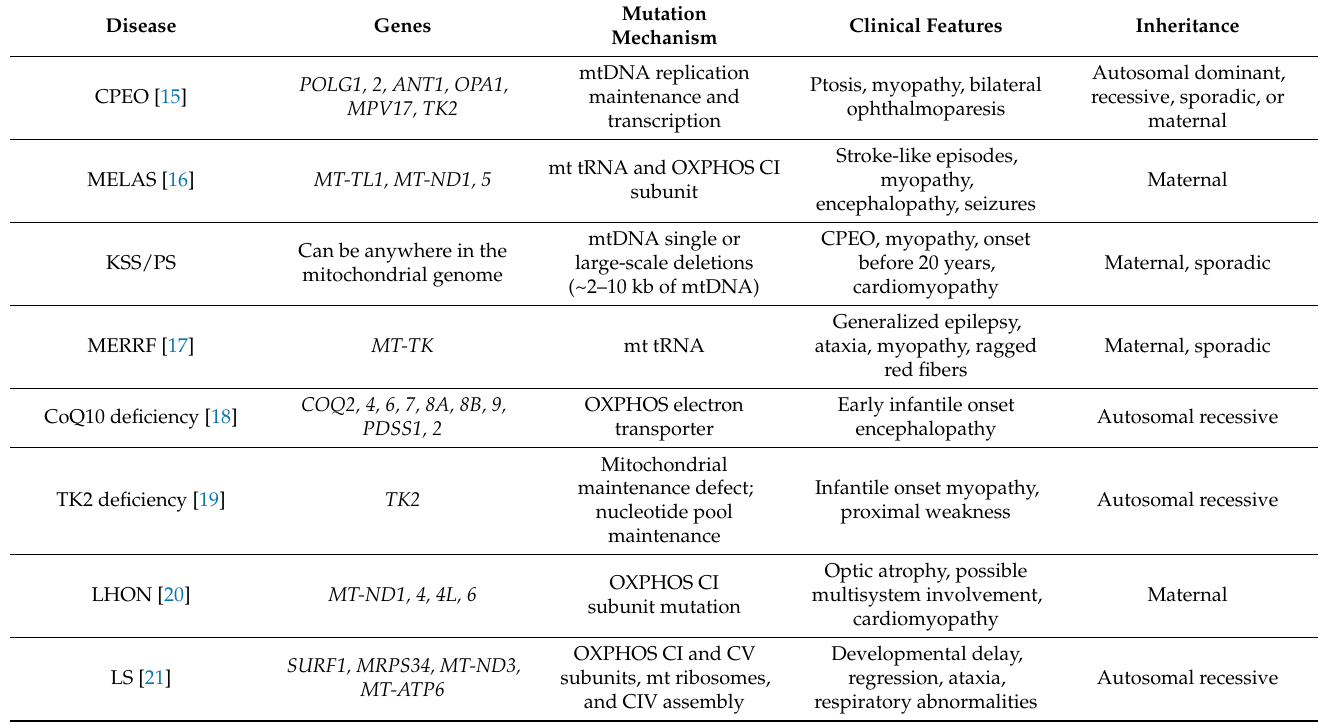
Table 1. Features of select mitochondrial